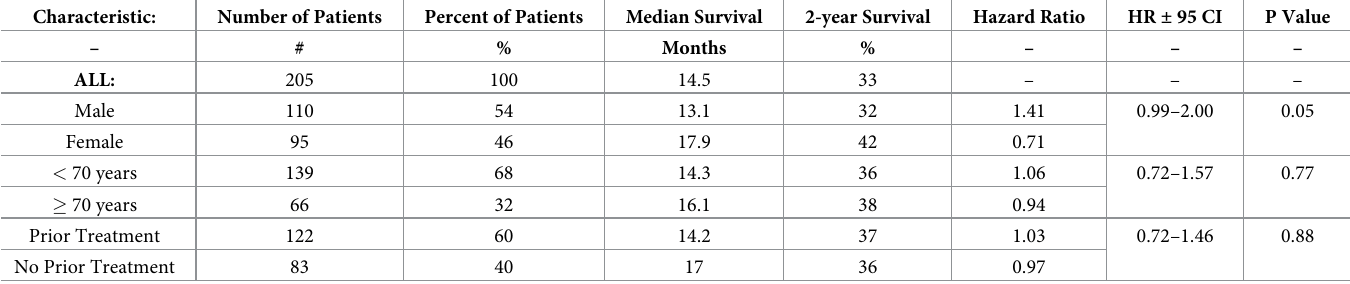
Table 2. Patient characteristics and